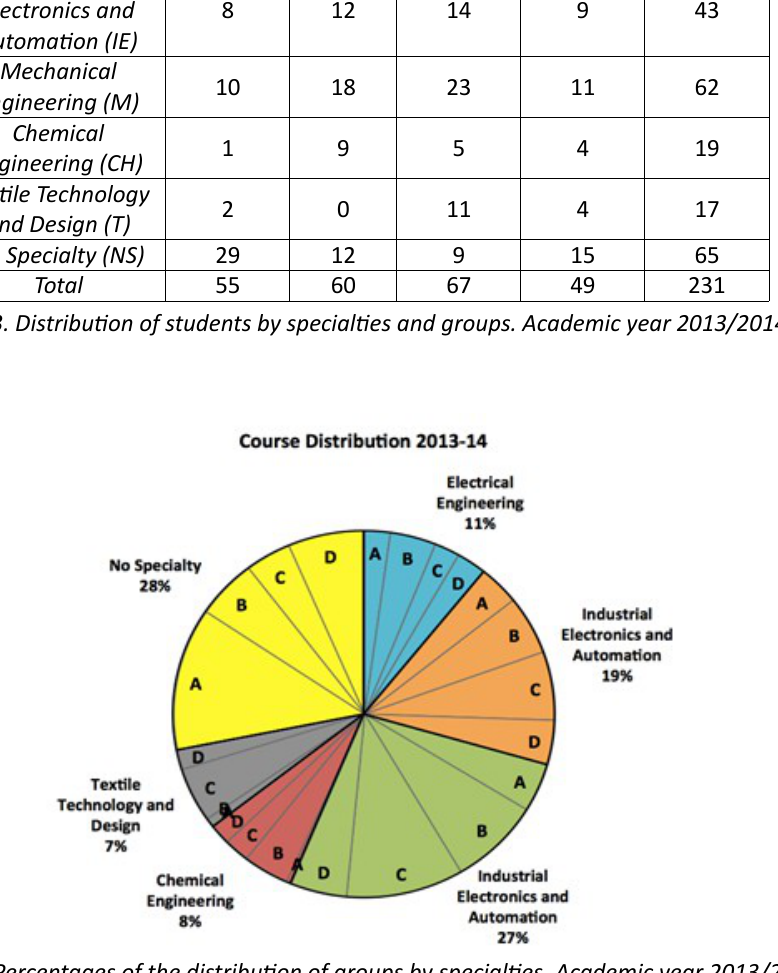
Figure 2. Percentages of the distributon of groups by specialtes. Academic year